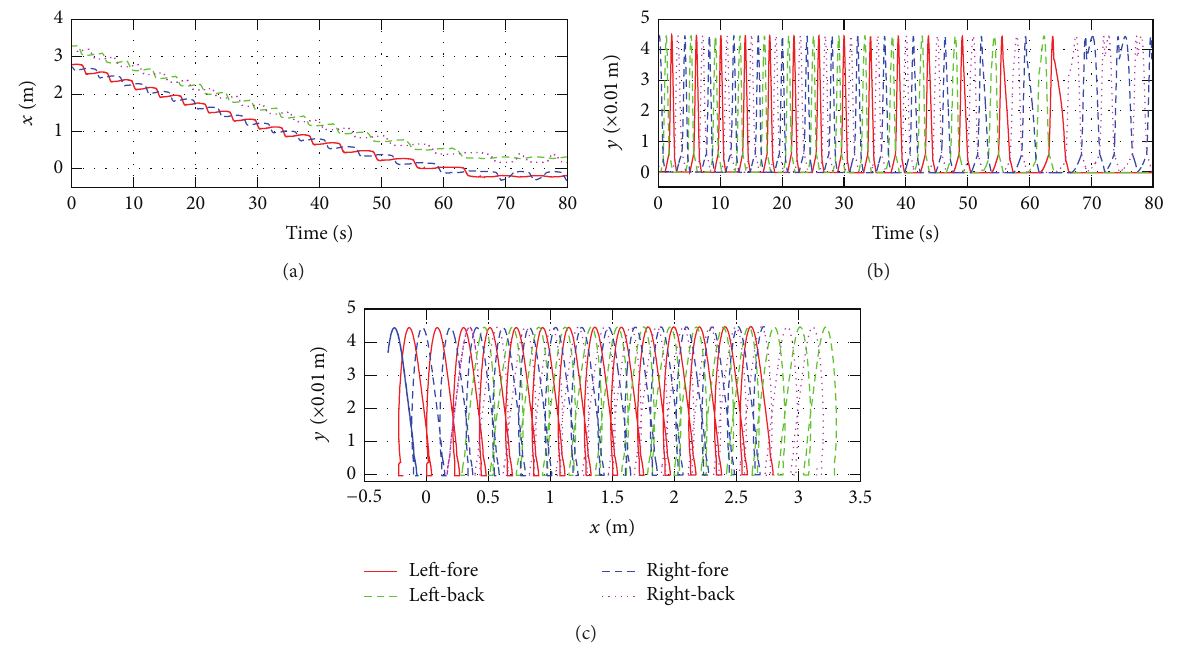
Figure 6: Time evolutions of 𝑥 -coordinate (a) and 𝑦 -coordinate (b) of the robot’s toes and the trajectory of the feet (c).